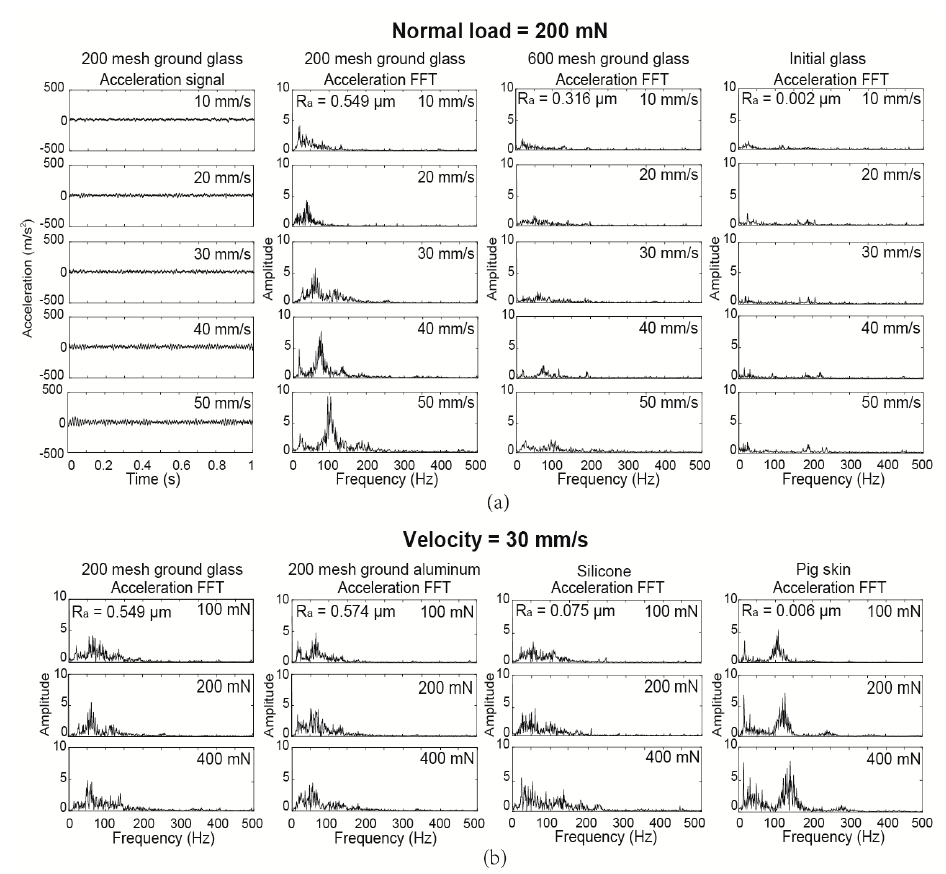
Figure 3. Glass, aluminum, silicone, and pig skin tactile perception ( a ) acceleration signal and frequency analysis (fast Fourier transform (FFT)) of three different roughness glass samples as a function of velocity ranging from 10 to 50 mm/s and a normal load equal to 200 mN; and ( b ) the frequency analysis (FFT) of four different hardness materials as normal load increases from 100 to 400 mN and with a sliding velocity equal to 30 mm/s.